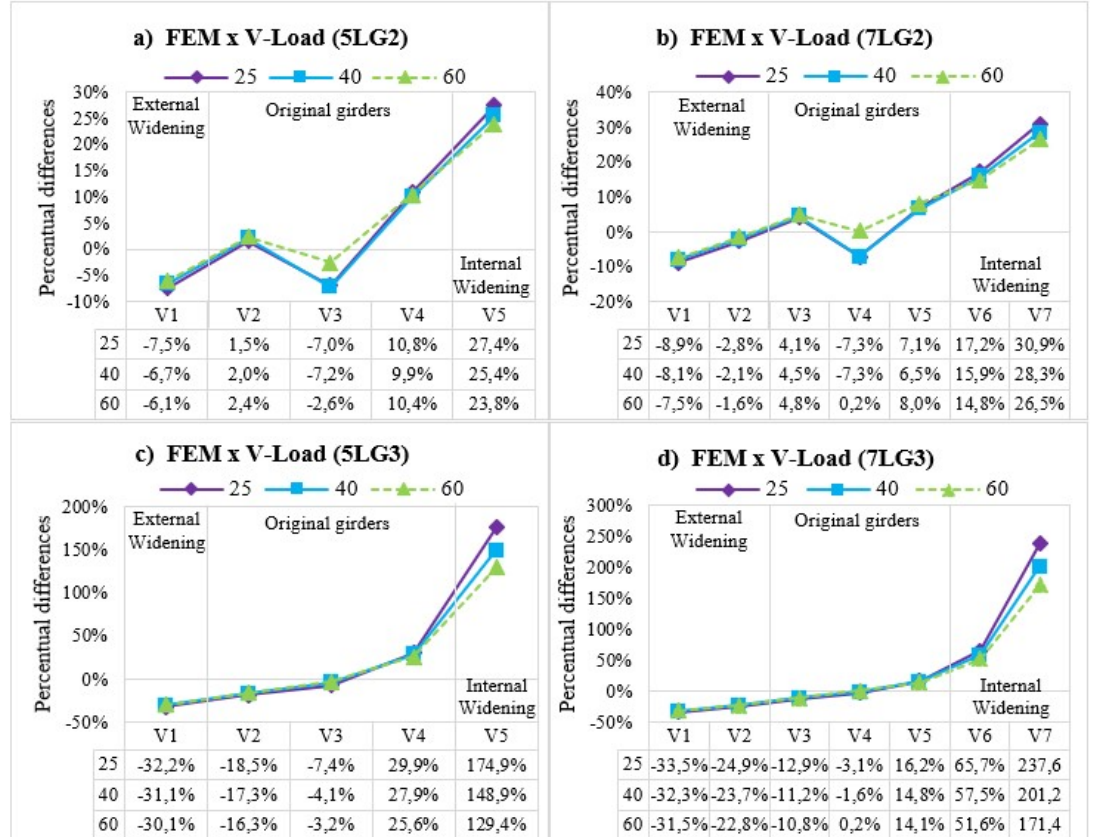
Figure 15. Local analysis between the FEM and the V-Load Method: (a) 5L-G2; (b) 7L-G2; (c) 5L-G3; (d) 7L-G3.